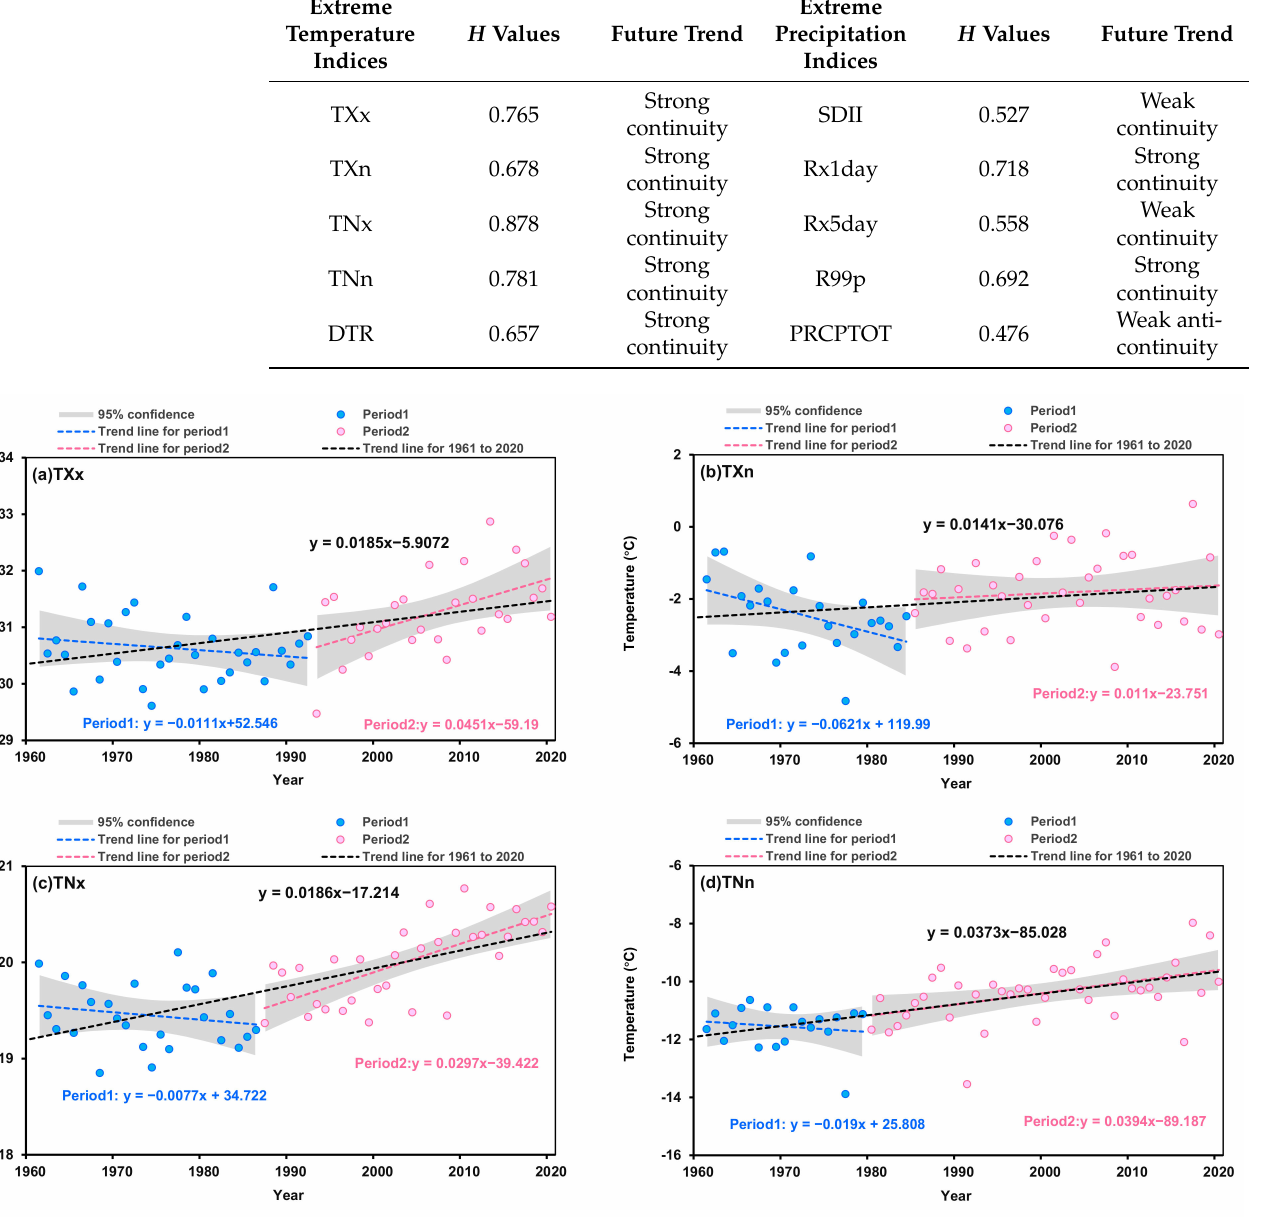
Hurst values for regional average of annual series in extreme temperature and precipitation indices.